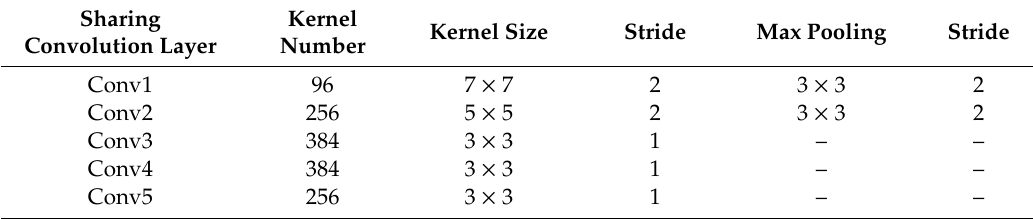
Table 1. Network configuration for the Zeiler and Fergus network